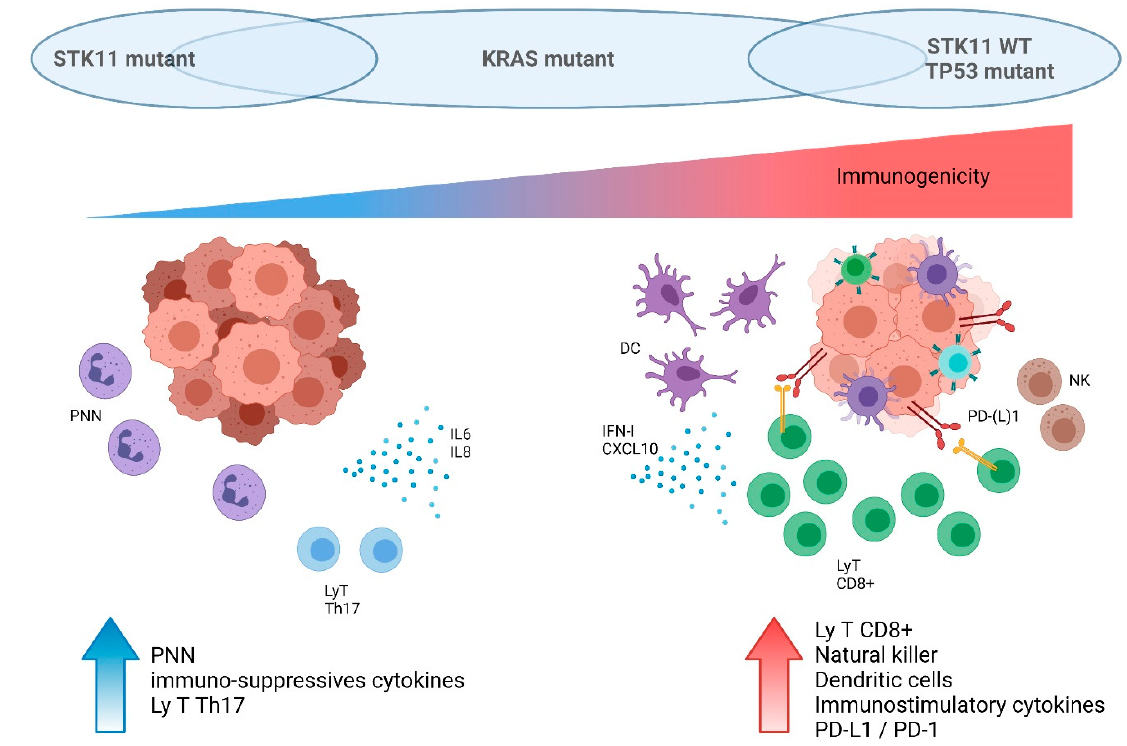
Figure 3. Schematic impact of KRAS , STK11 , and TP53 status on immune cell tumor microenvironment in lung cancer. This figure was created with BioRender.com (accessed on 1 October 2021).